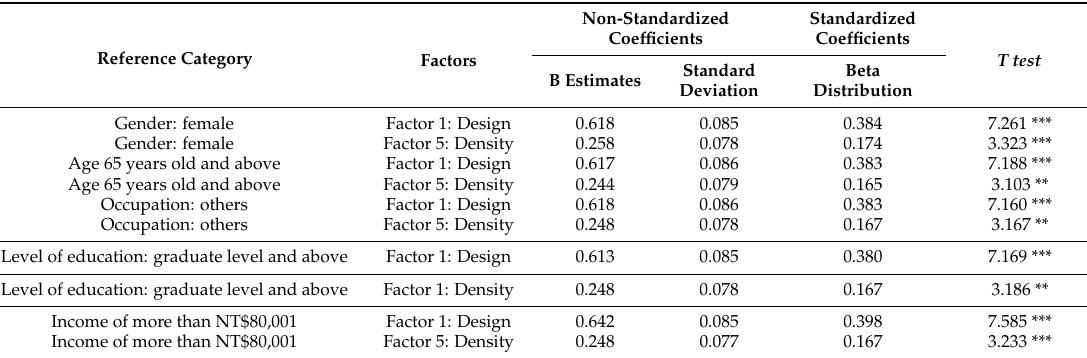
Table 7. Residents’ personal characteristics and residential